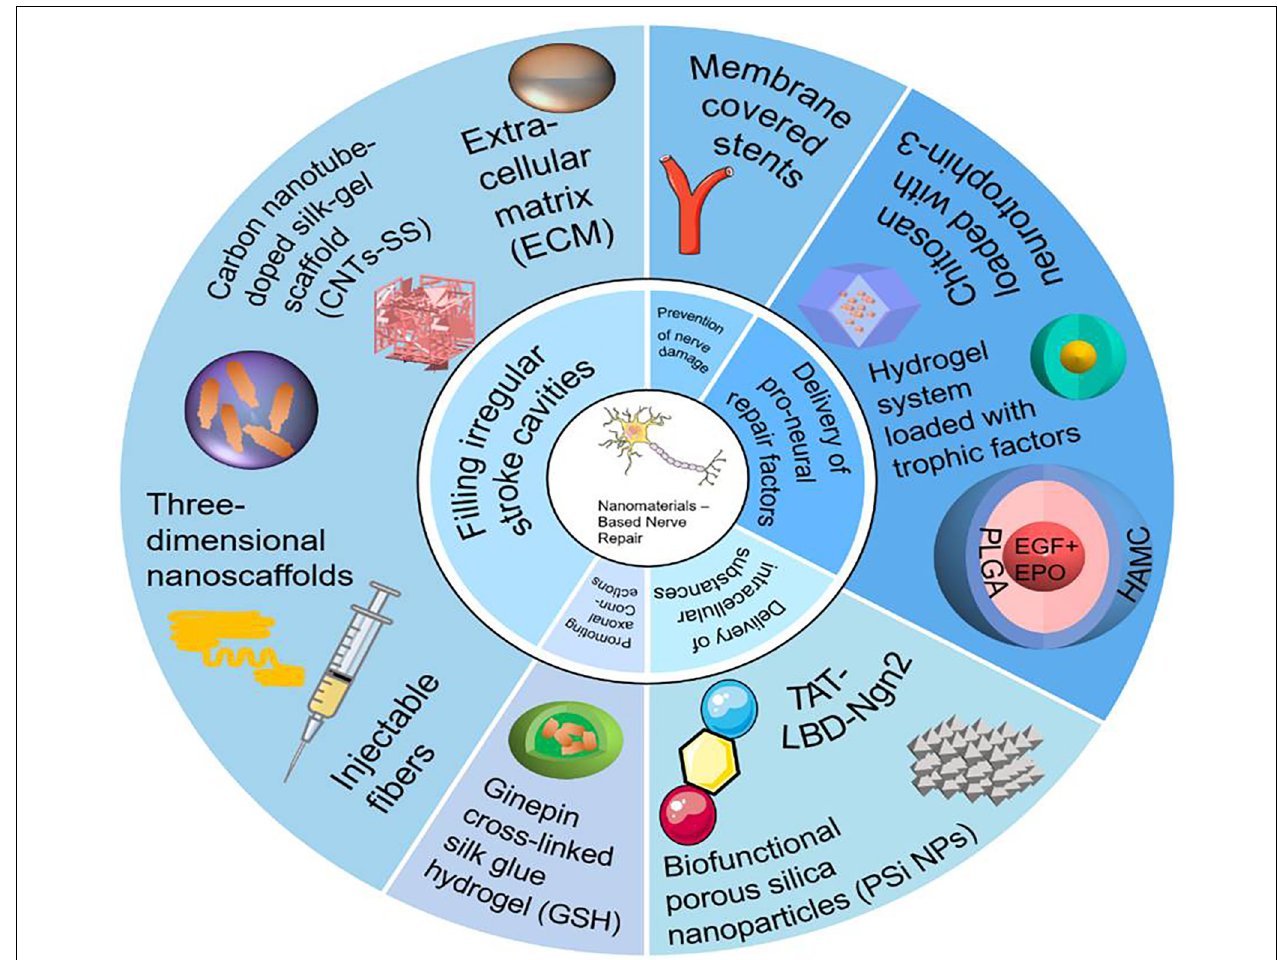
FIGURE 7 | Nanomaterial-based neuroprotection approach